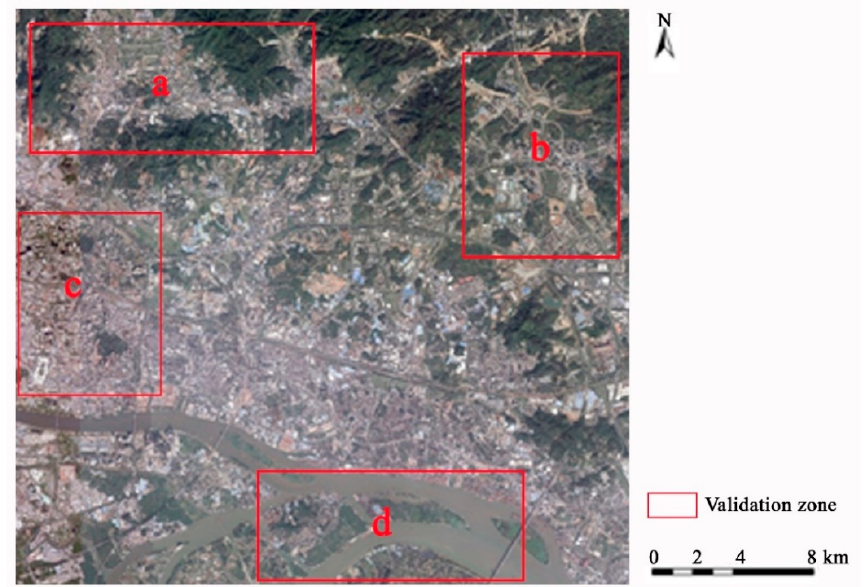
Figure 10. Four validation zones: ( a ) urban–rural fringe zones, ( b ) areas with abundant bare soil, ( c ) central business district (CBD) areas, and ( d ) riverside.